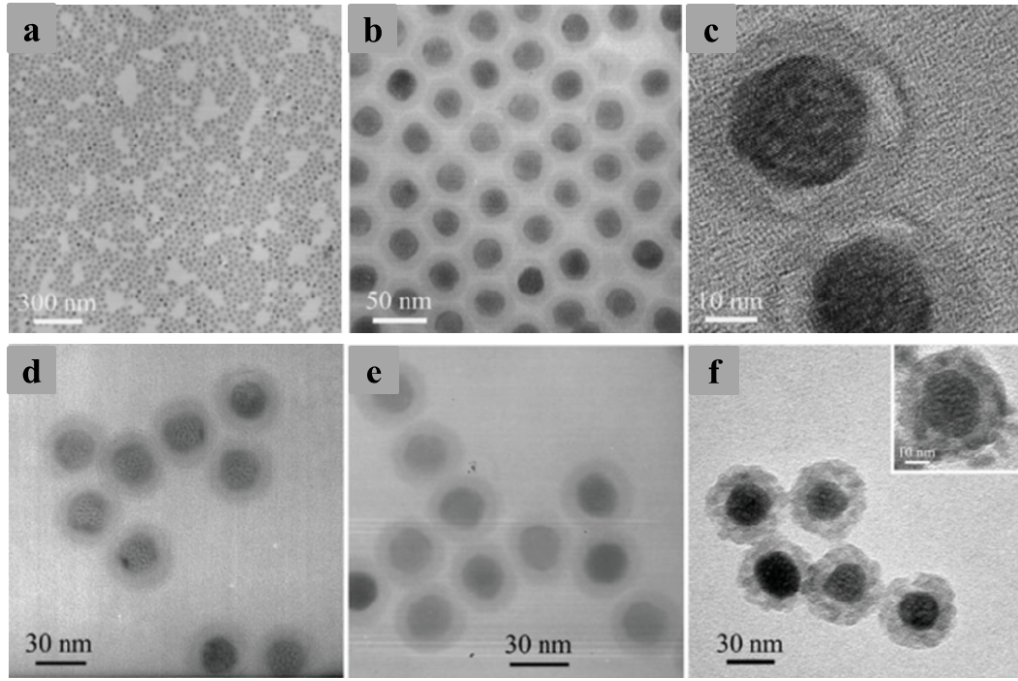
Figure 6: a–c) TEM images of silica-coated NaYF 4 :Yb,Er nanospheres at different magnifications. TEM images of d) FITC doped